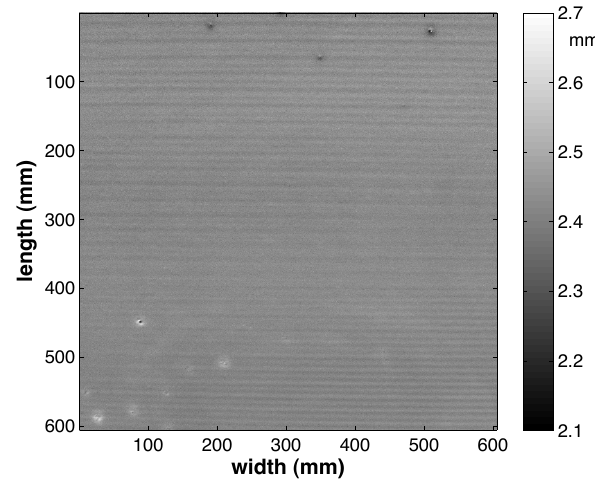
Fig. 4. Relative topography between two milk level